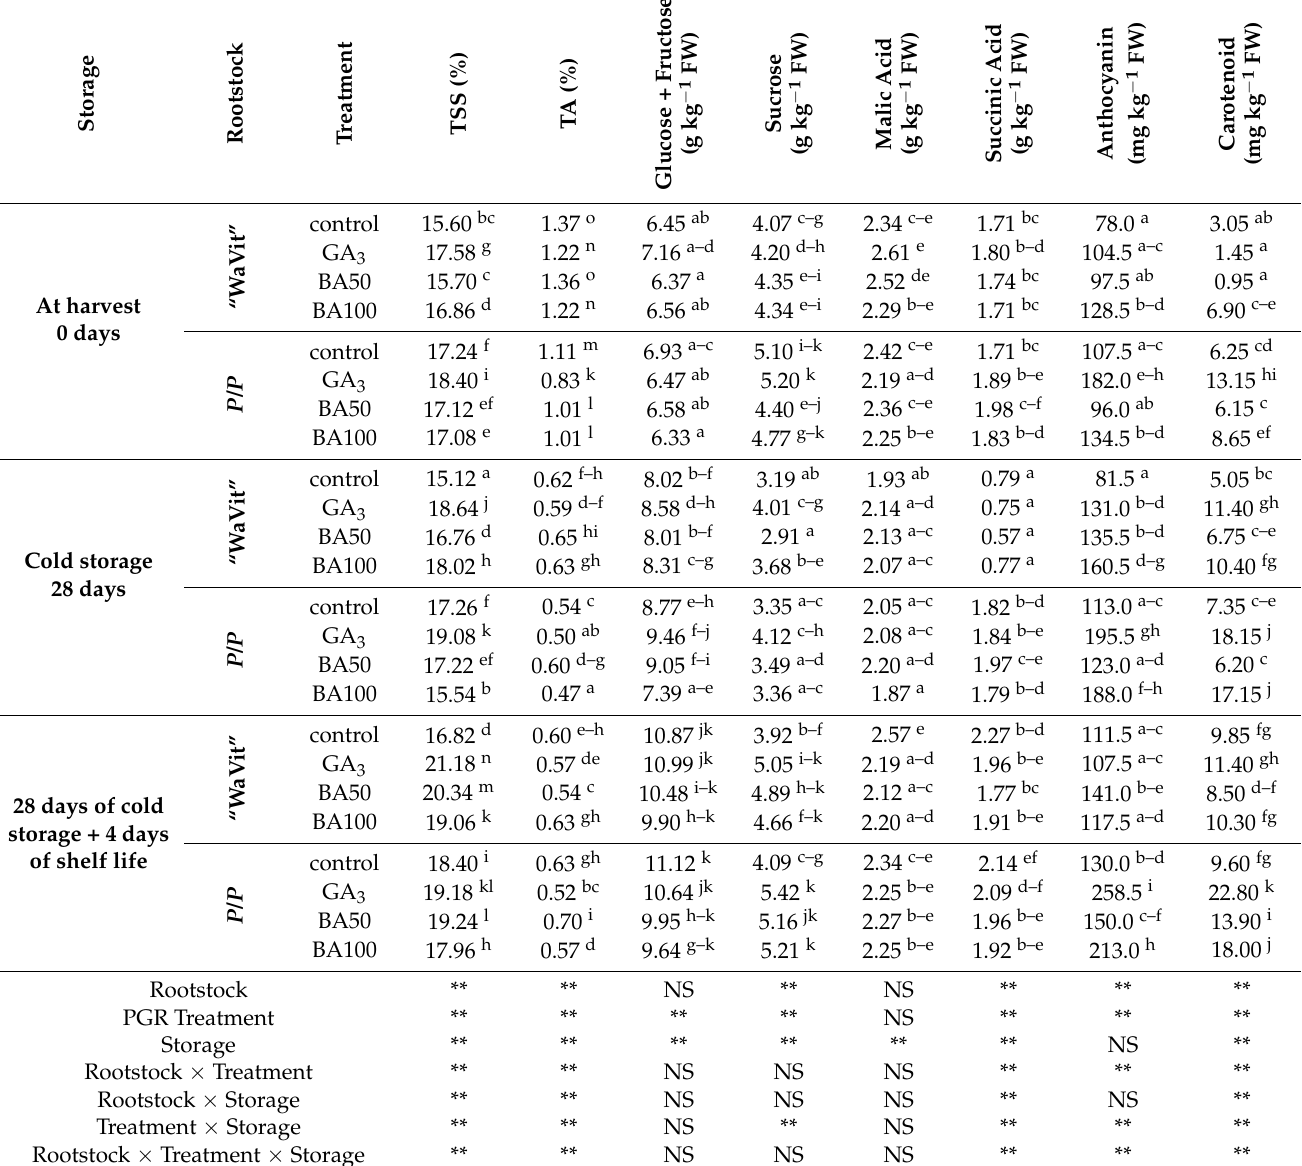
Table 3. Changes in pigment, sugar and acid content in fresh and stored plums grown on two different rootstocks (“WaVit” and P. cerasifera / P. spinosa ) influenced by PGR